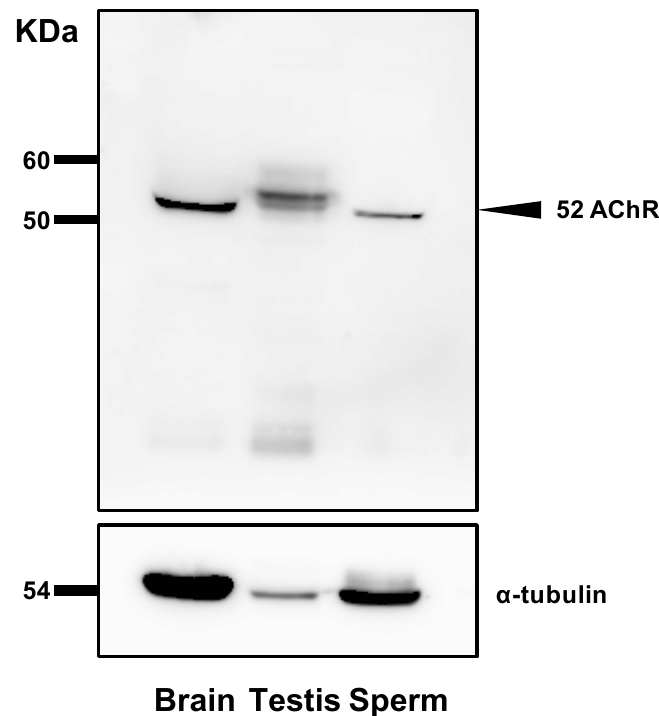
Figure 2. Acetylcholine receptor ε subunit (AChRe) expression analysis by western blotting. Protein extracts from mouse sperm, testes, and positive control (brain) samples (30 µ g) were separated by 10% SDS-PAGE followed by detection with specific antibodies. Note the specific band corresponding to AChRe at the predicted size.